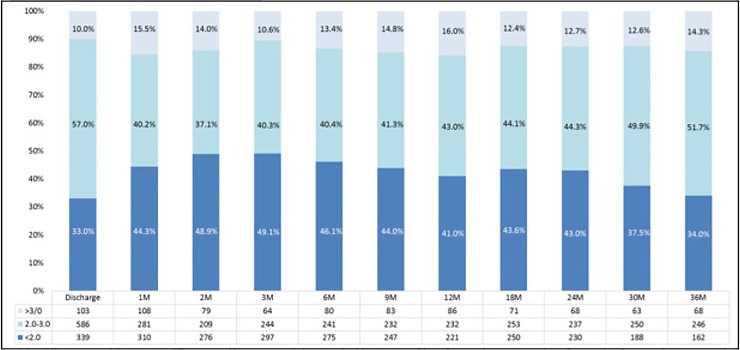
Primary outcome events according to modified iTTR.iTTR, individual time in therapeutic range.